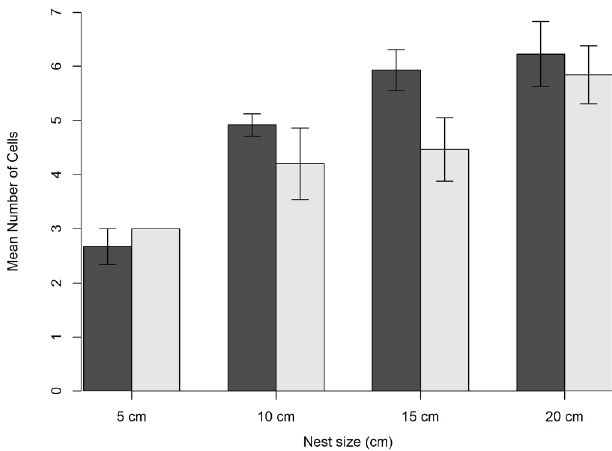
Fig 1 . Mean number of brood cells provisioned in trap-nests of different lengths. Centris analis (= dark gray bars), Tetrapedia diversipes (= light gray bars).